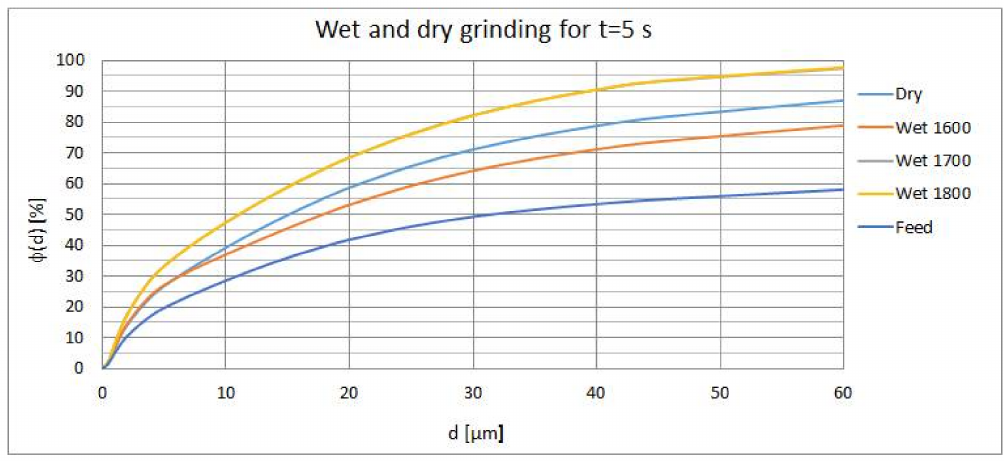
Figure 16. Comparison of cumulative volume curves for the dry and wet grinding process (t = 5 s).